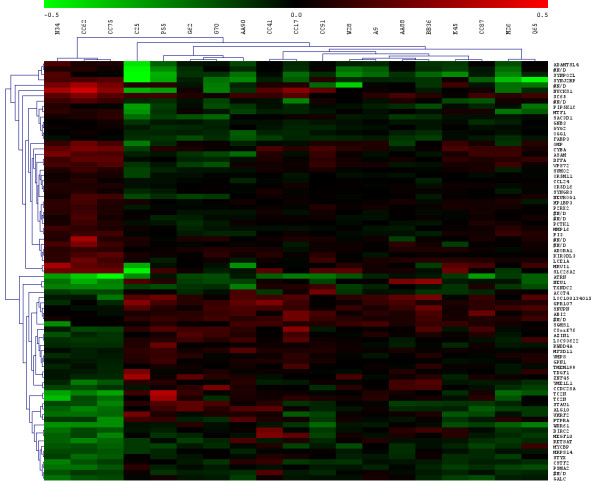
Cluster analysis applied to EGFRhigh: a 79-gene signature separated EGFRhigh/mutated samples(N34, CC62, CC75)from EGFRhigh/WT samples. (G70, C25, A9, E45, M26, AA88, AA90, BB36, CC17, CC41, CC87, CC91, G62, P55, Q65, W28). (N34, CC62, CC75, G70, C25, A9, E45, M26, AA88, AA90, BB36, CC17, CC41, CC87, CC91, G62, P55, Q65, W28 referred to patients code as in additional file 1, table S1)